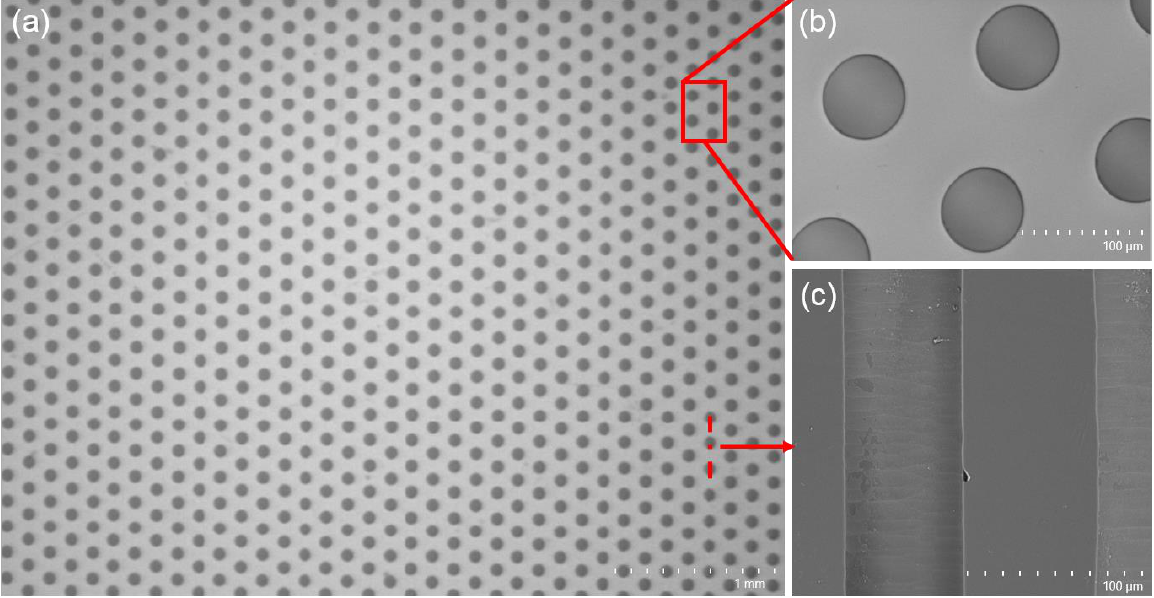
Figure 6. Hole array sample picture. ( a ) A highly consistent hole array taken by the second element equipment. ( b ) An enlarged view of a basic element of the hole array by optical microscope. ( c ) A cross-section of the hole captured by SEM (scanning electron microscope).